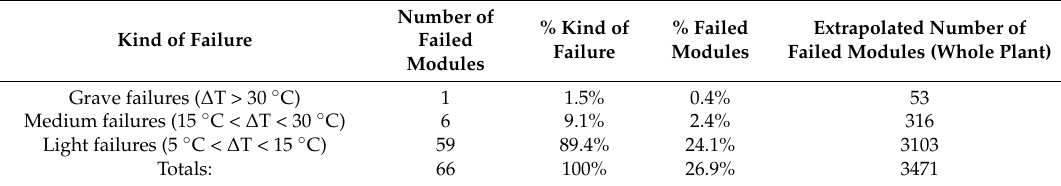
Table 3. Statistics of failures in photovoltaic modules detected by thermography in a 245 module sector of the Y é char solar plant. Percentages are shown for the kind of failure and proportion of overall total number of inspected modules. Last column: An extrapolation of possible failed modules, taking into account the total number of modules (12,885) and the statistics of previous